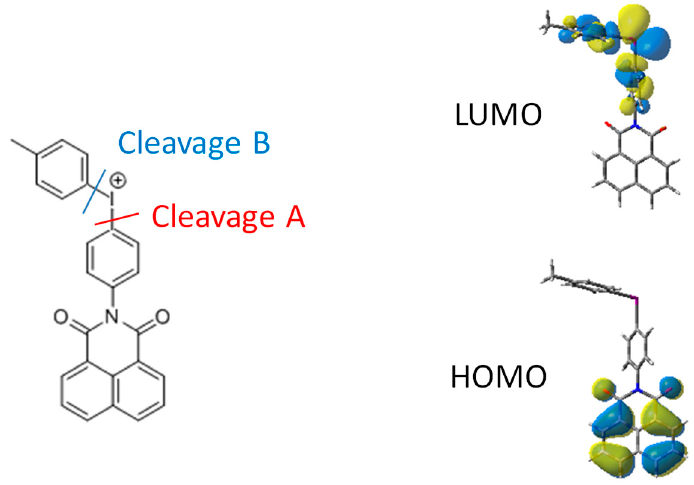
Figure 4. UV-vis absorption spectra for the most reactive iodonium salts ( 3 , 5 , and 6 ) in acetonitrile for a concentration of 1 × 10 − 4 M.